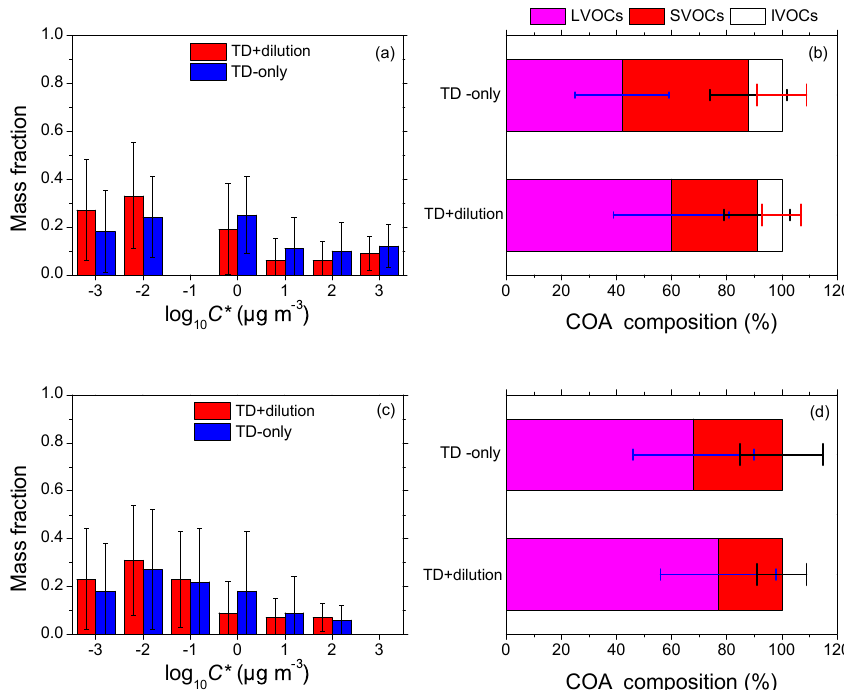
Figure 7. (a) Estimated volatility distributions of the COA along with their uncertainties of Experiment 1 using the approach of Karnezi et al. (2014). Red bars represent the volatility distribution using the combination of thermodenuder and isothermal dilution measurements whereas blue bars represent the volatility distribution using only thermodenuder measurements (b) Corresponding COA compositions for the two cases of (a) along with their corresponding uncertainties ( ± 1 standard deviation). LVOCs are in magenta, SVOCs in red, and IVOCs in white. The uncertainty range of IVOCs, SVOCs, and LVOCs are shown in red, black, and blue, respectively. (c) Estimated volatility distributions of the COA of Experiment 2 using the approach of Karnezi et al. (2014). Red bars represent the volatility distribution using the combination of thermodenuder and isothermal dilution measurements whereas blue bars represent the volatility distribution using only thermodenuder measurements. (d) Corresponding COA compositions for the two cases of (c) along with their corresponding uncertainties ( ± 1 standard deviation). LVOCs are in magenta and SVOCs in red. The uncertainty ranges of SVOCs and LVOCs are shown in black and blue,